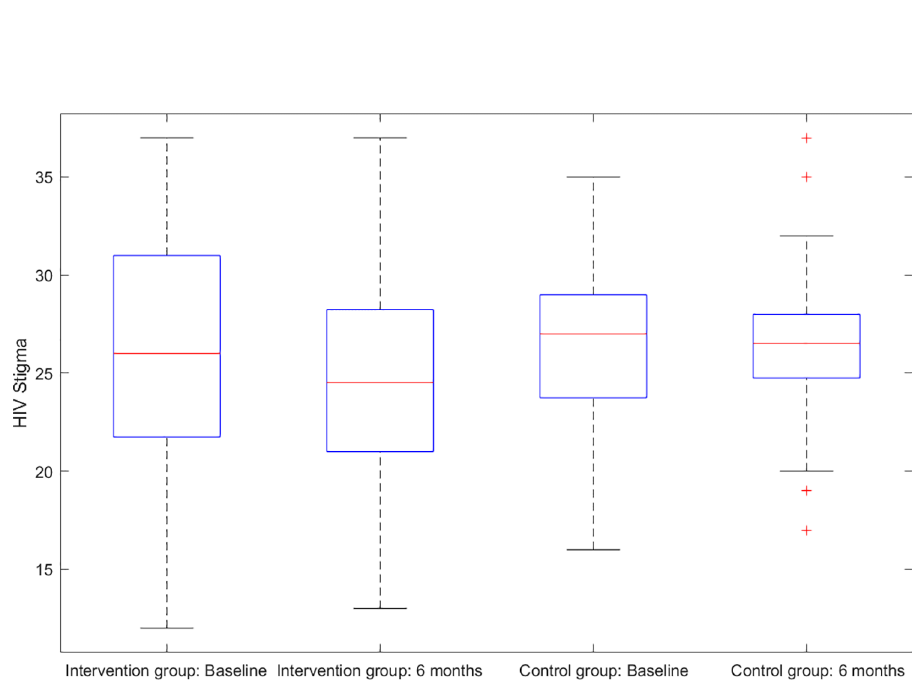
Fig 5. Boxplots of HIV stigma for treatment and control groups at baseline and 6-month visits.